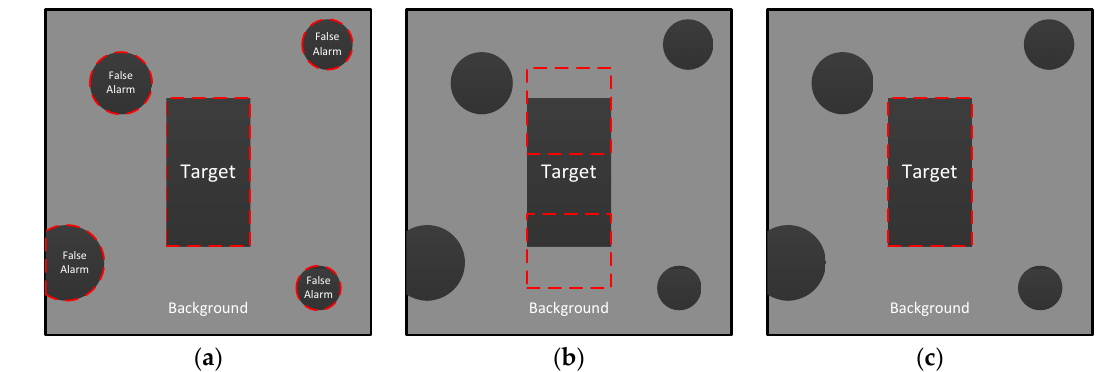
Figure 2. Schematic diagram of the proposed algorithm. The gray rectangles represent the shadow of the moving target, the gray circles represent false alarms from a low-RCS background, and the red dashed lines represent the detection boxes. ( a ) Results of background frame detection. ( b ) Results of multi-interval frame difference. ( c ) Result of fusion and threshold determination.